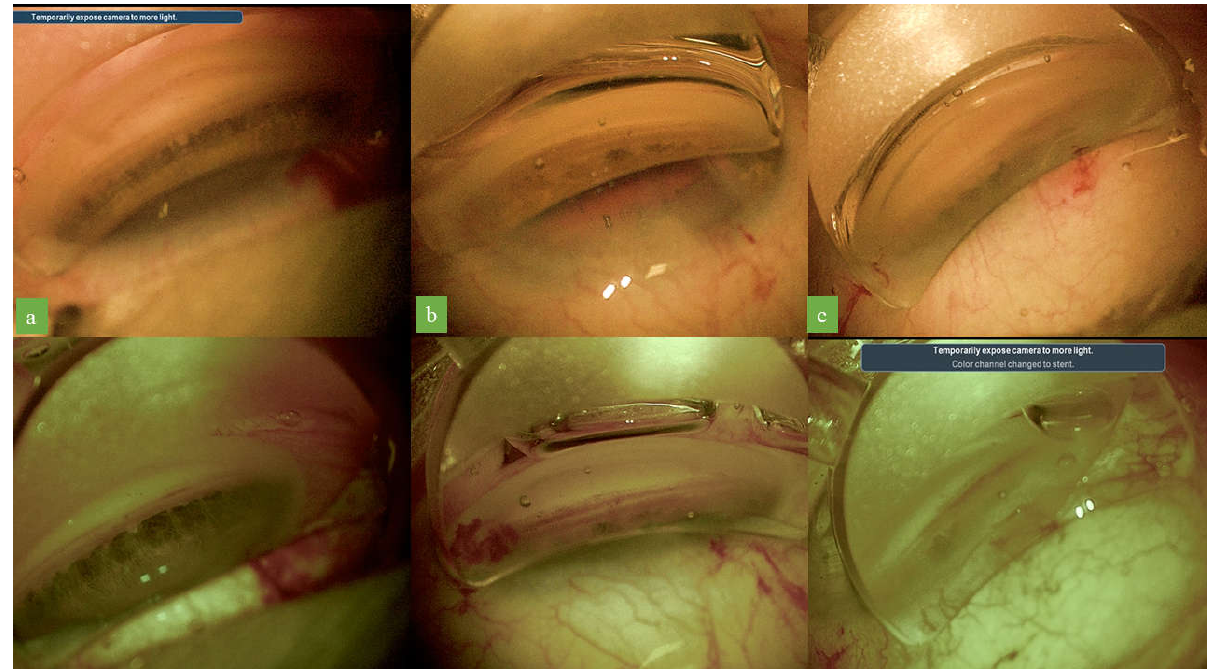
Figure 2. Standard colors gonioscopic images in three cases ( a – c ) and corresponding images after optimized digital settings application. Visualization of both the pigmentation of the trabecular meshwork and Schlemm’s canal was enhanced with the optimized digital system.